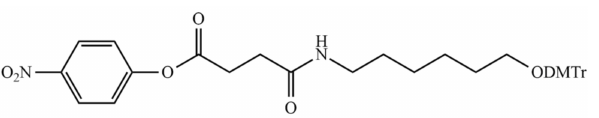
Figure 6. Example of a bifunctional linker connecting peptide and oligonucleotide